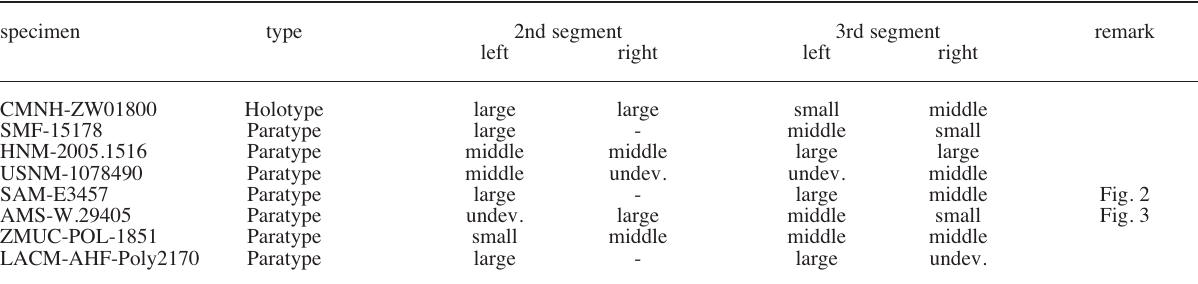
AMS-W.29405 Fig. 3